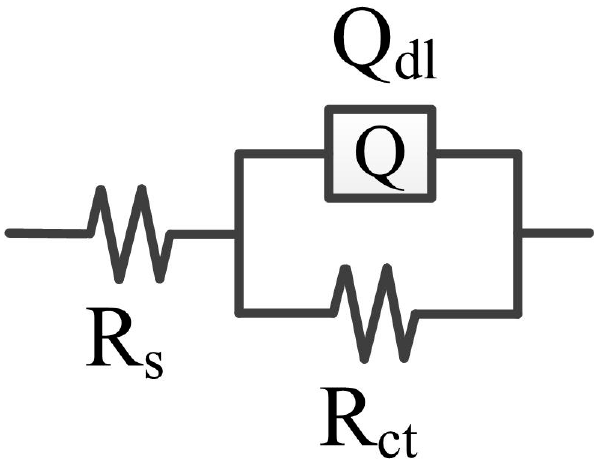
Figure 10. EEC for the analysis of the EIS of the CrFeCoNi and CrMnFeCoNi coatings at open circuit potential condition in 3.5 wt% NaCl solution. Table 3. EEC fitting parameters for electrochemical impedance spectra in 3.5 wt% NaCl solution under OCP condition.